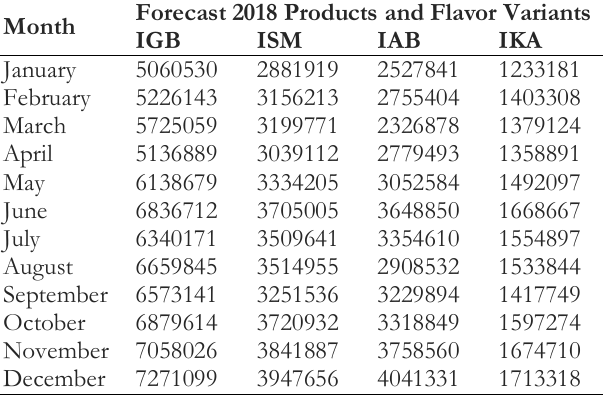
Table 3. Forecasting